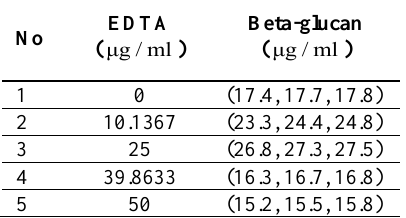
Table 6. Fuzzy data set for EDTA and BG.